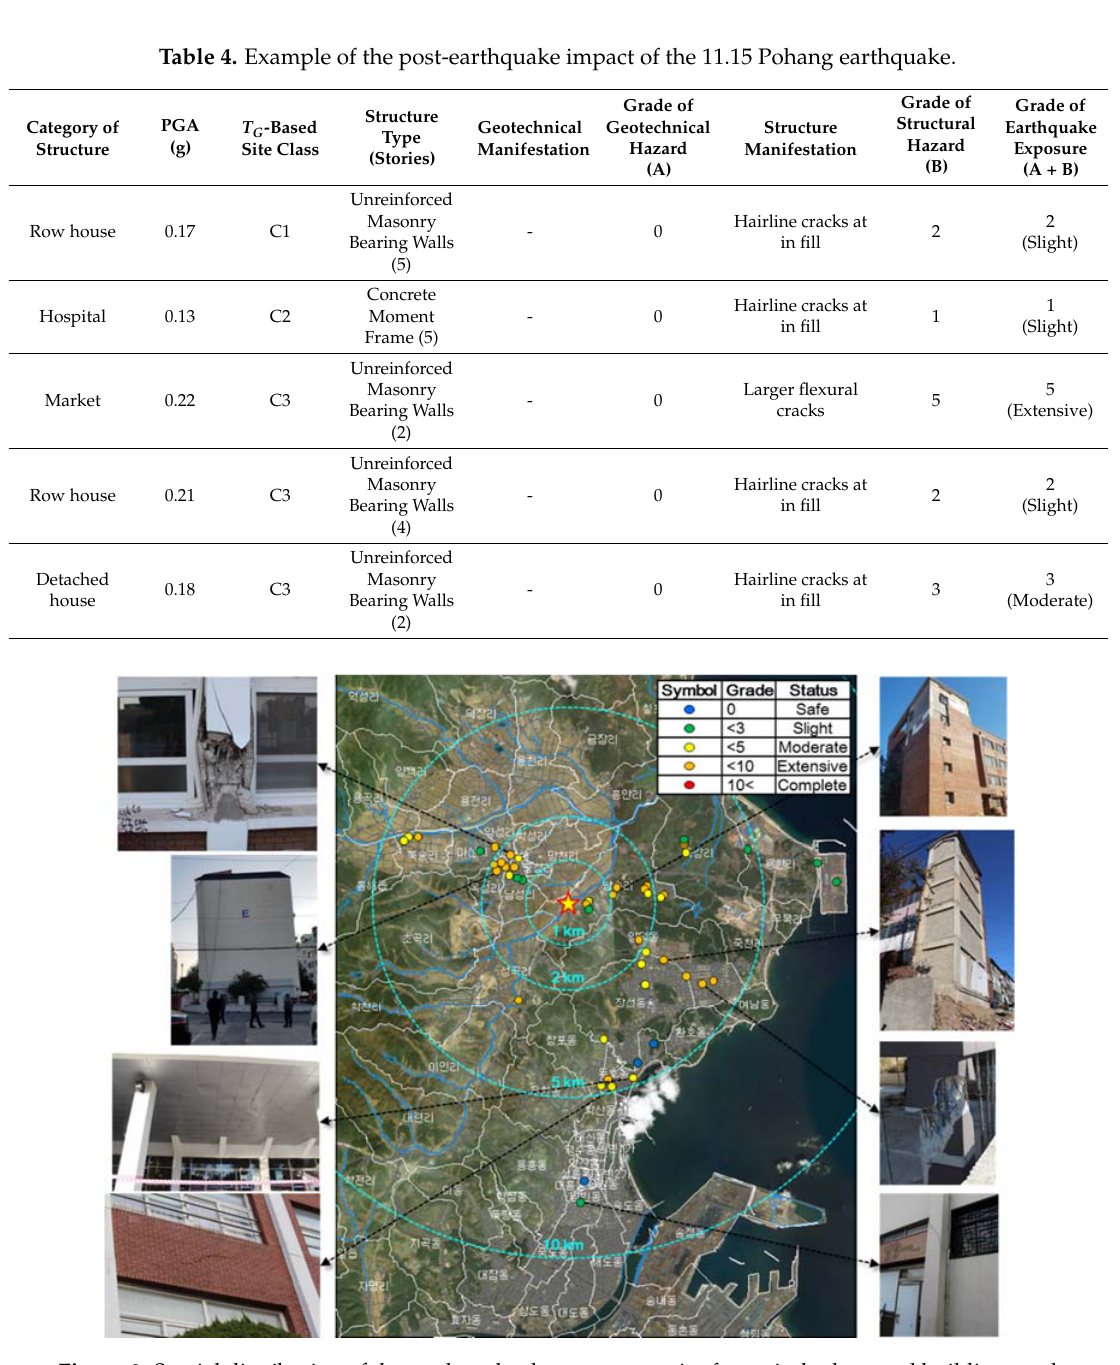
Figure 8. Spatial distribution of the earthquake damage categories for majorly damaged buildings and images of buildings.